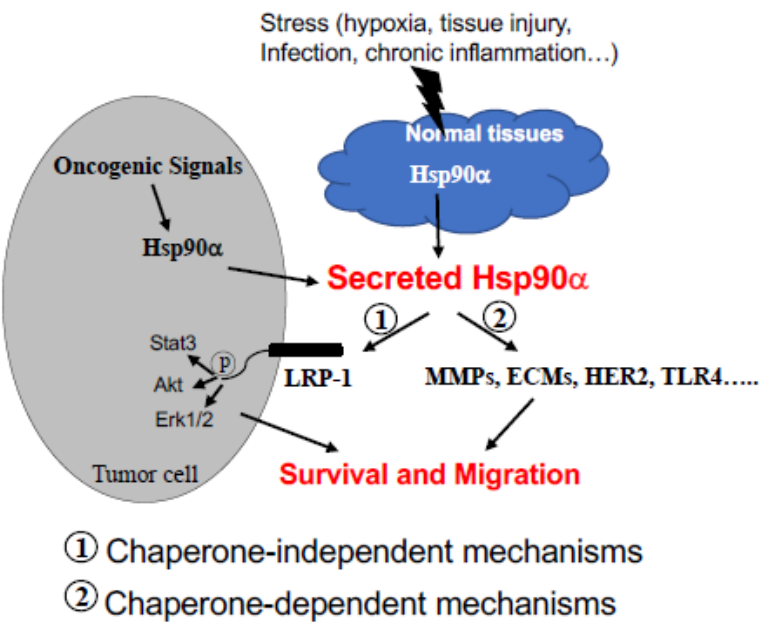
Figure 4. Two proposed mechanisms of action by eHsp90 α . eHsp90 α acts via an ATPase-dependent or ATPase-independent mechanism, which is determined by different binding partners, as shown.